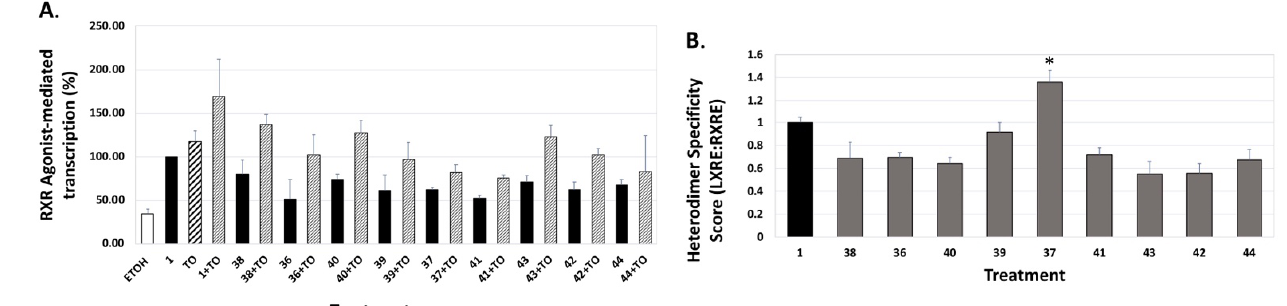
Figure 8. Evaluation of RXR agonists to potentiate LXRE-mediated transactivation in the absence and presence of LXR ligand T0901317 . ( A ) U87 glial cells were transfected with an expression vector for human LXR α , an LXRE-luciferase reporter gene with three tandem copies of the LXRE from the human ApoE gene, and a Renilla control plasmid. Cells were transfected for 24 h utilizing a liposome-mediated transfection protocol and then treated with ethanol vehicle, or 100 nM of the indicated compound alone or in combination with 100 nM TO901317 (TO). LXRE-directed activity was compared to compound 1 (Bexarotene), set to 100%. ( B ) The “Heterodimer Specificity Score” was determined by the LXRE:RXRE ratio with compound 1 set to 1.0. All error bars represent standard deviations; the data are representative of at least three independent experiments with six replicates in each treatment group. * p < 0.05 versus control compound 1.